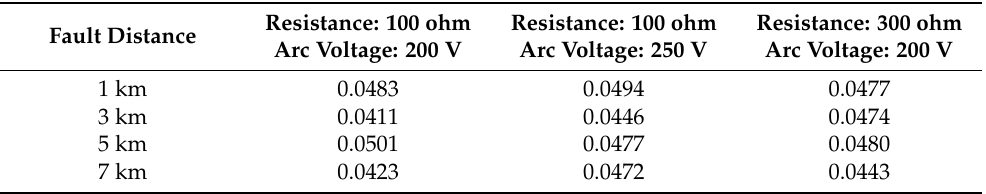
Table 4. Standard deviation of singular value in low frequency layer under different fault Table 3. Mean value of low frequency singular value under different fault conditions.